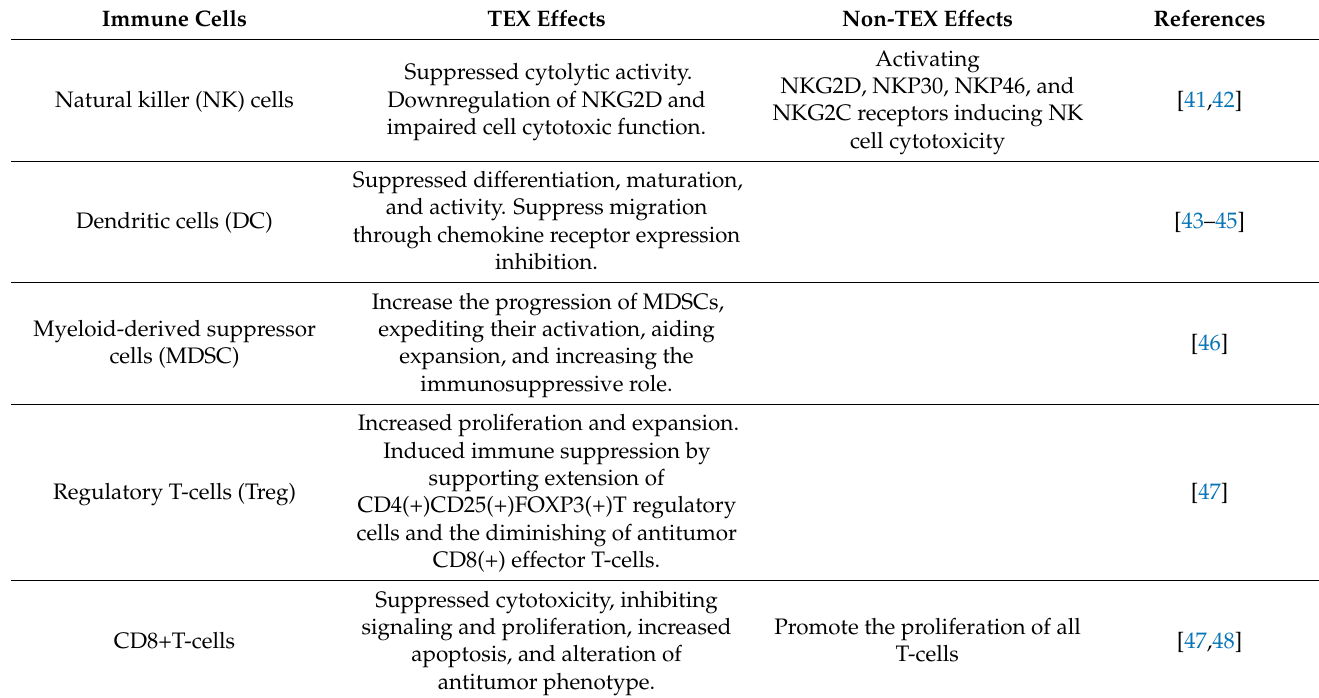
Table 1. Role of tumor-derived exosomes (TEX) in